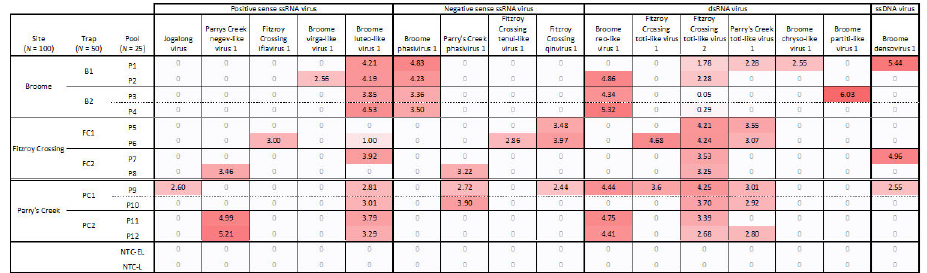
Figure 5. Heat map of HTS reads mapped against viral sequences found in Cx. annulirostris mosquitoes. Values represent the log 10 of specific virus-mapped reads per 10,000,000 reads normalized against total reads per